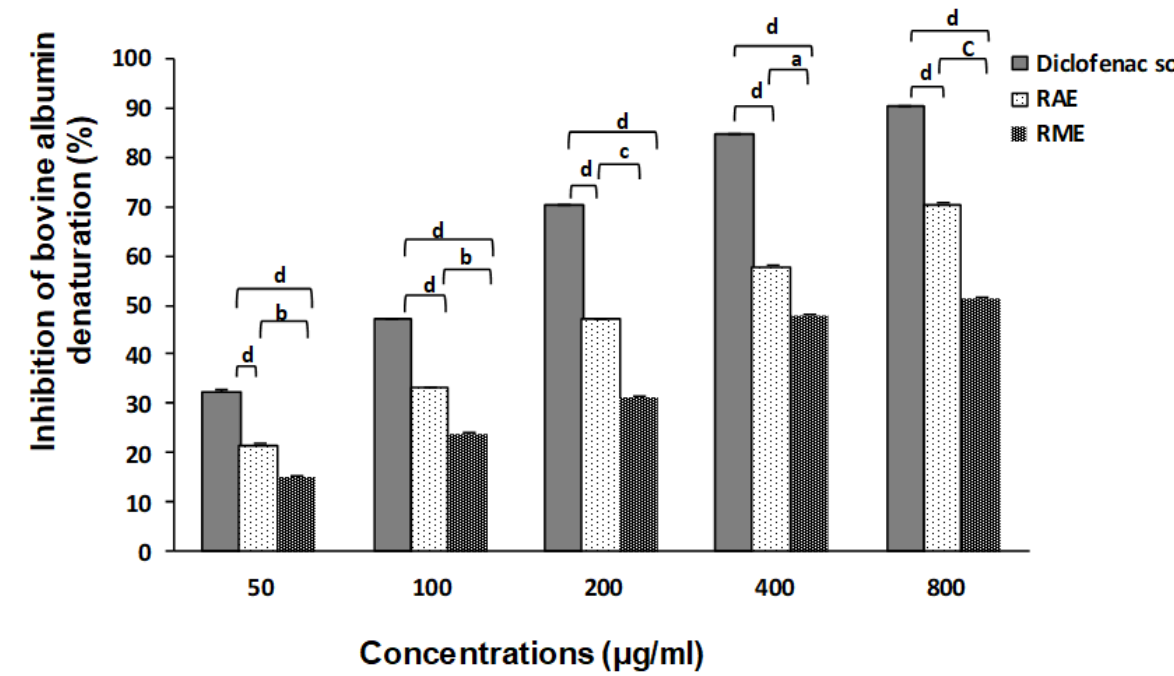
Figure 3. Effect of R. tuberculata extracts on albumin denaturation. Values were expressed as mean ± SD ( n = 5). Mean values followed by different letters are significantly different (based on one-way ANOVA followed by Tukey’s multiple comparison tests. Level of Significance: a p < 0.05, b p < 0.01, c p < 0.001, d p < 0.0001).